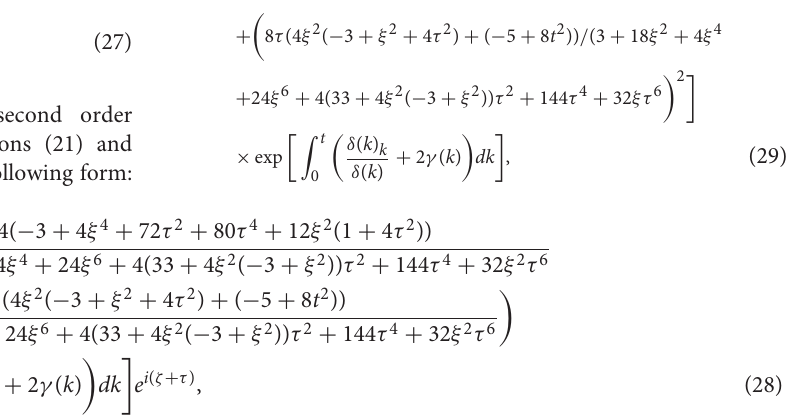
0.5, (B) b 0.79 and δ 0 ( t ) = = 0.35 t 2 , δ ( t ) 0.1 1.2cos(0.1 t ), and δ 0 ( t ) = = +